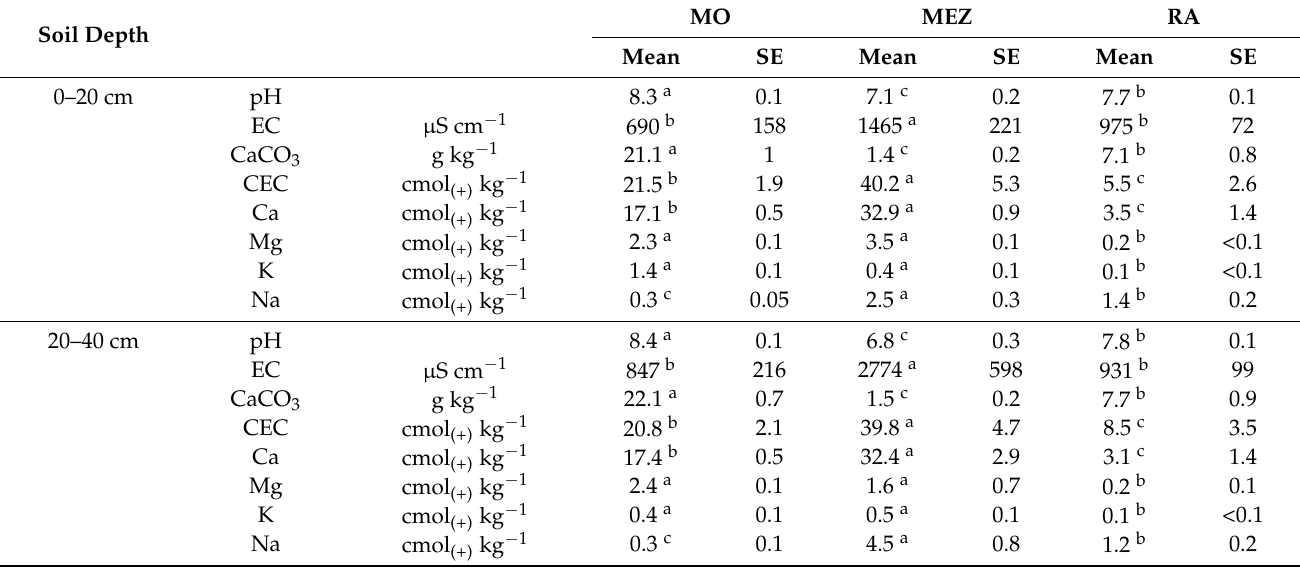
Table 1. Mean and standard error (SE) values of soil pH, electrical conductivity (EC), CaCO 3 content, cation exchange capacity (CEC), contents of exchangeable Ca, Mg, K and Na in 0–20 and 20–40 cm soil layers of processing tomato fields located in Modena (MO), Ferrara (MEZ) and Ravenna (RA) provinces, Emilia Romagna Region, Italy. Different letters mean significant differences (Kruskal–Wallis test, p < 0.05) among sites within 0–20 and 20–40 cm soil layers. Soil